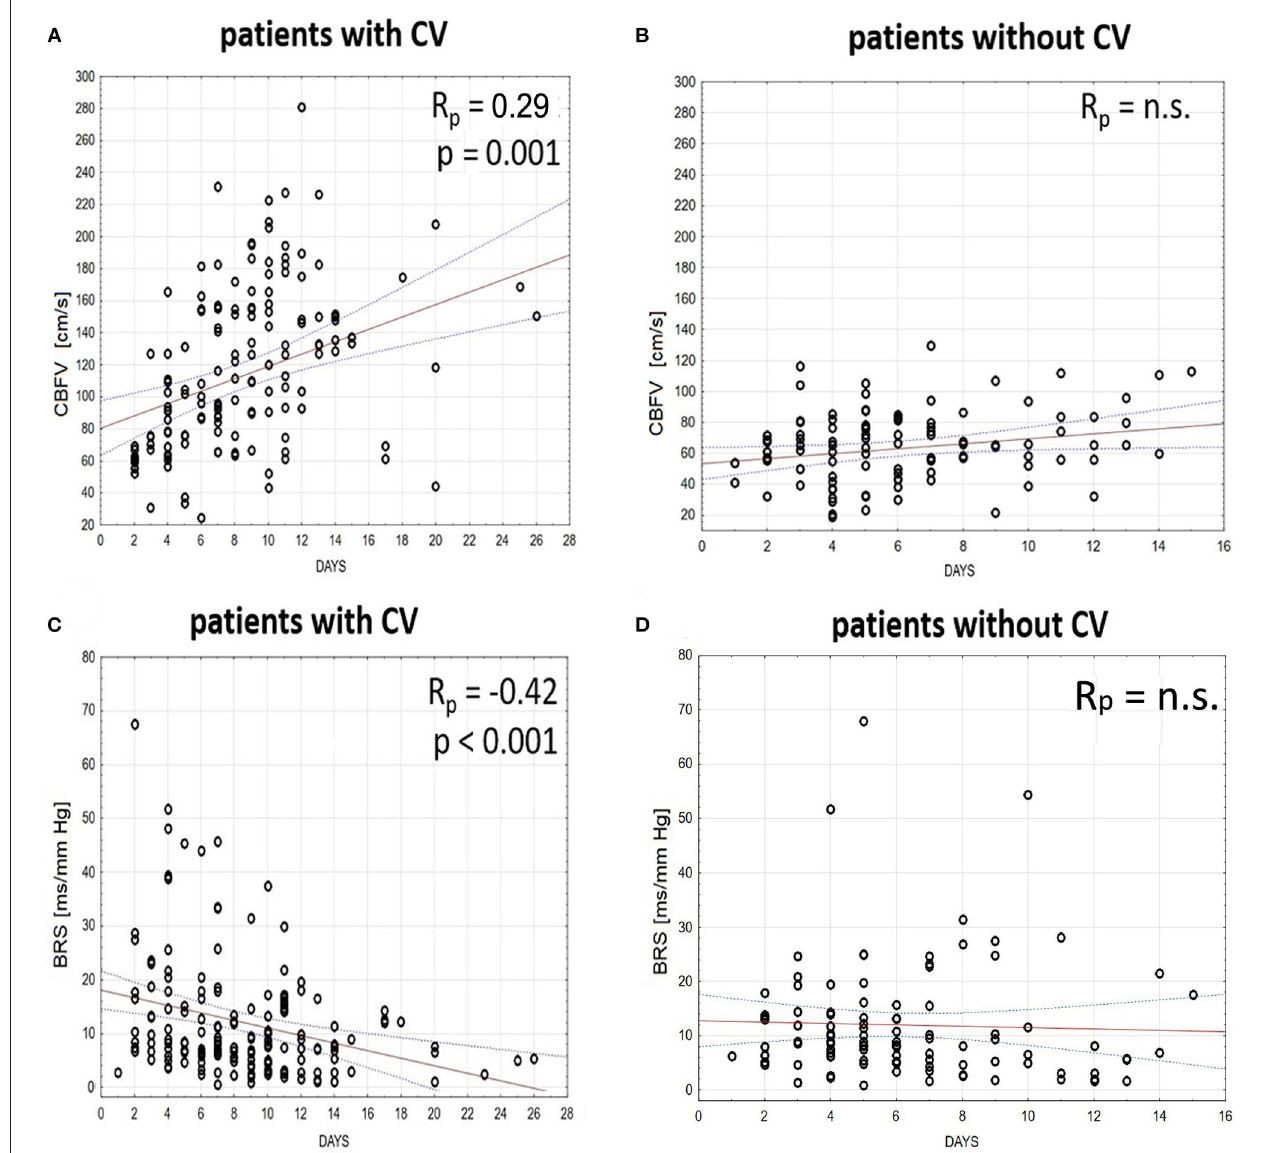
FIGURE 4 | Time trends (solid red line) and the 95% CI (dashed line) of (A,B) cerebral blood flow velocity (CBFV) and (C,D) baroreflex sensitivity (BRS) in patients (A,C) with and (B,D) without cerebral vasospasm (CV) analyzed in the days that follow aneurysmal subarachnoid hemorrhage (aSAH). The relationship between days and physiological parameters was calculated using multiple linear regression analyses with subjects treated as categorical factors using dummy variables (with respect to the intersubject variability) and a partial coefficient (R p ) between analyzed